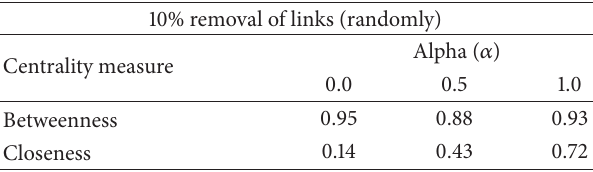
Table 3: Fifteen percent random removal effect of links.